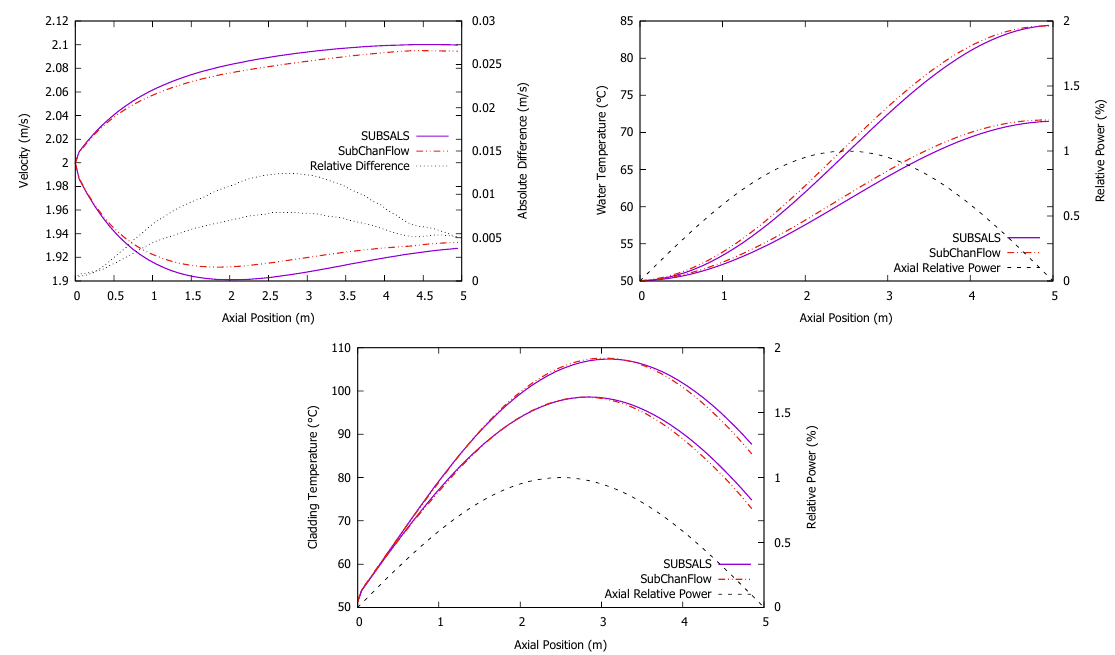
Figure 9. Comparison of axial velocity (top left), water temperature (top right) and cladding temperature (bottom) distribution calculations with sine axial power